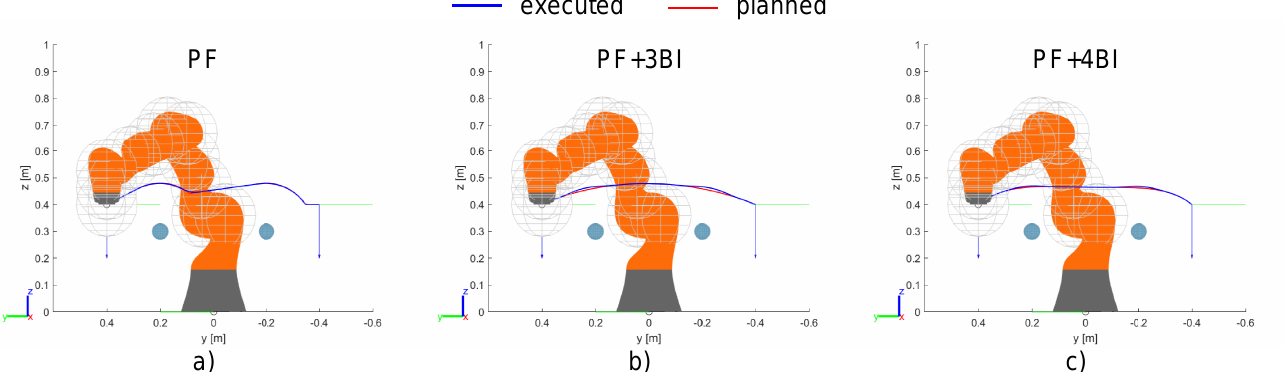
Figure 18. Example 4: comparison between different methods for path generation; ( a ) Potential Fields, ( b ) Potential Fields with 3rd order Bézier Interpolation, ( c ) Potential Fields with 4th order Bézier Interpolation.